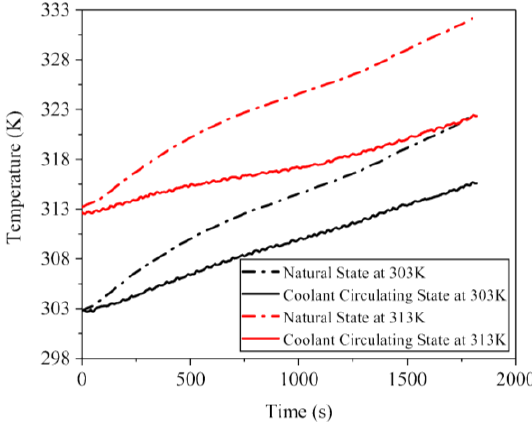
Figure 6. The comparison of experimental results.